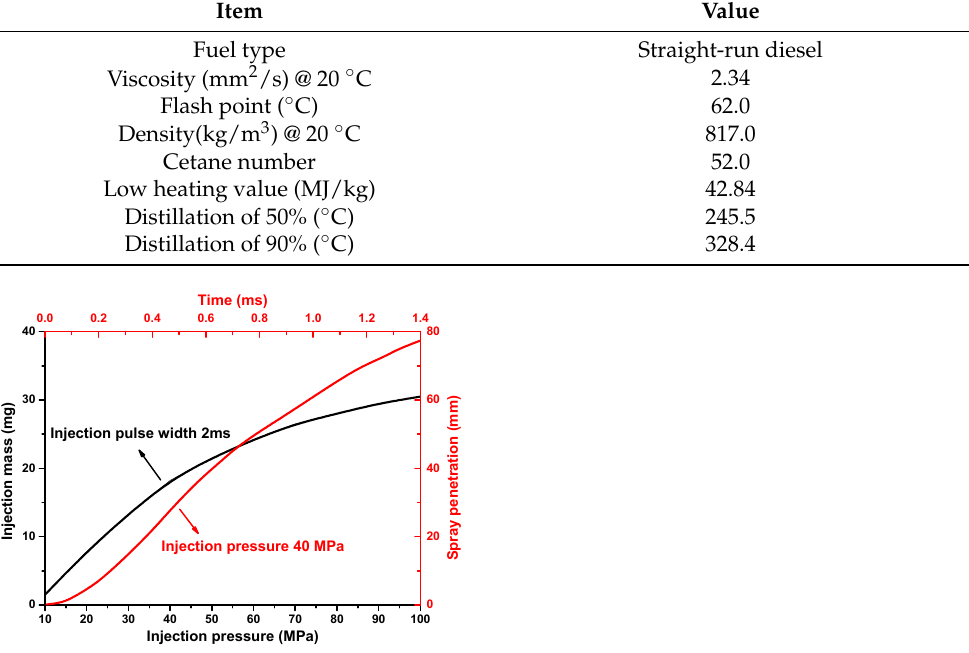
Figure 2. Calibration results of injection mass versus injection pressure and spray penetration versus time.